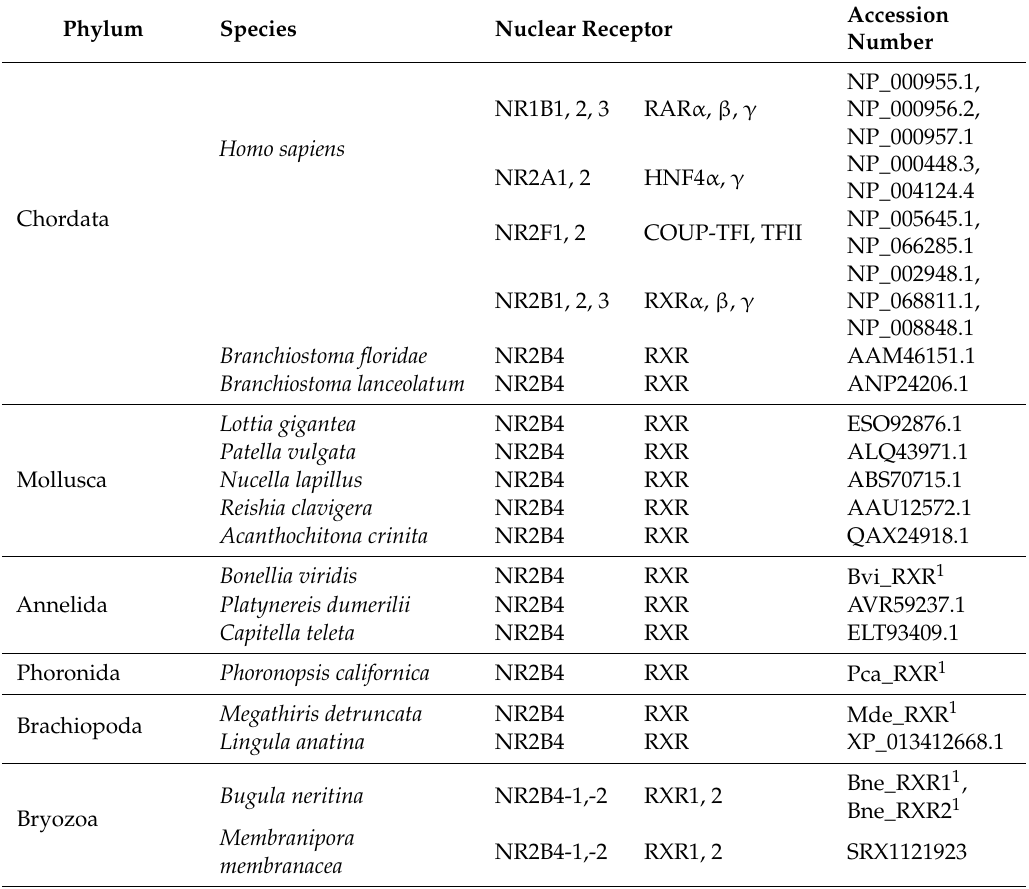
Table 1. List of sequences used for the phylogenetic analysis of retinoid X receptor (RXR) in metazoan lineages and the corresponding accession